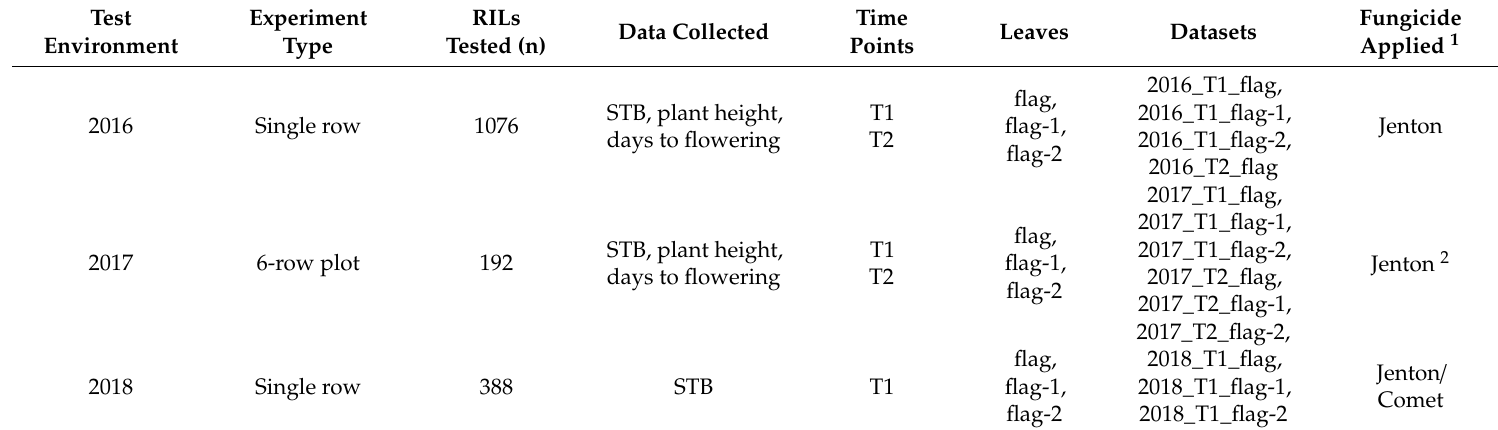
Table 1. Summary of experiments performed in this study at the adult plant stage for scoring septoria tritici blotch (STB) response across years and management